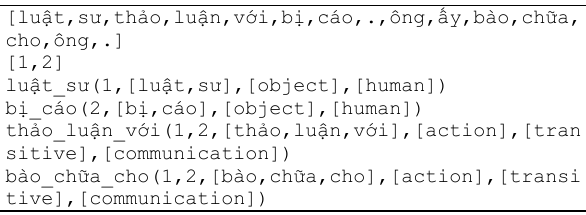
Figure 23. The DRS with main predicates of two- sentences Vietnamese paragraph “Luật sư thảo luận với bị cáo. Ông ấy bào chữa cho ông.”